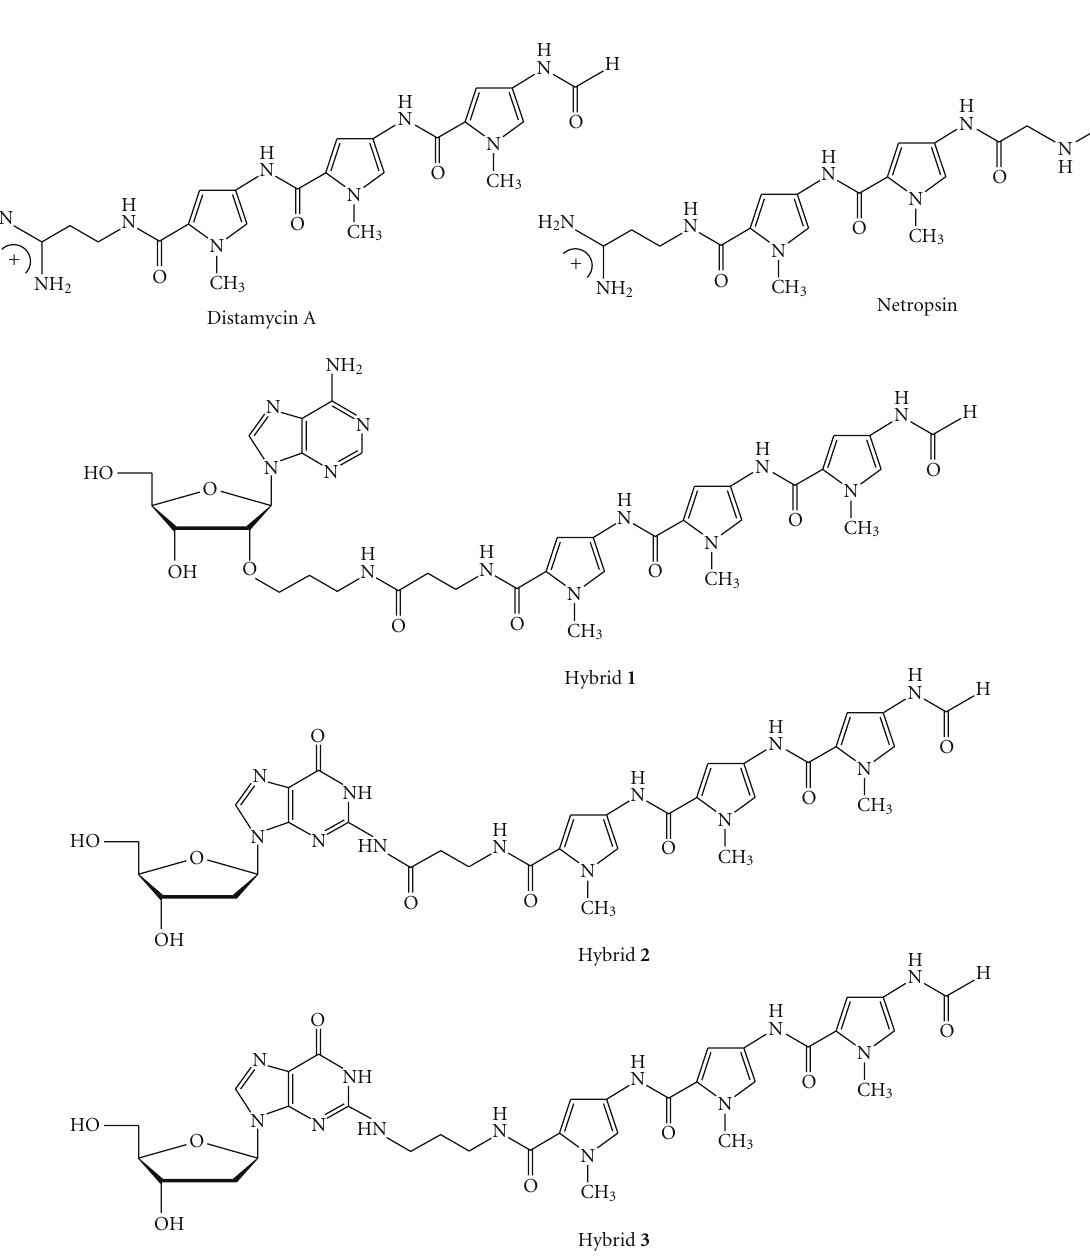
Figure 1: Structures of Distamycin A, Netropsin, Hybrid 1 , Hybrid 2 , and Hybrid 3